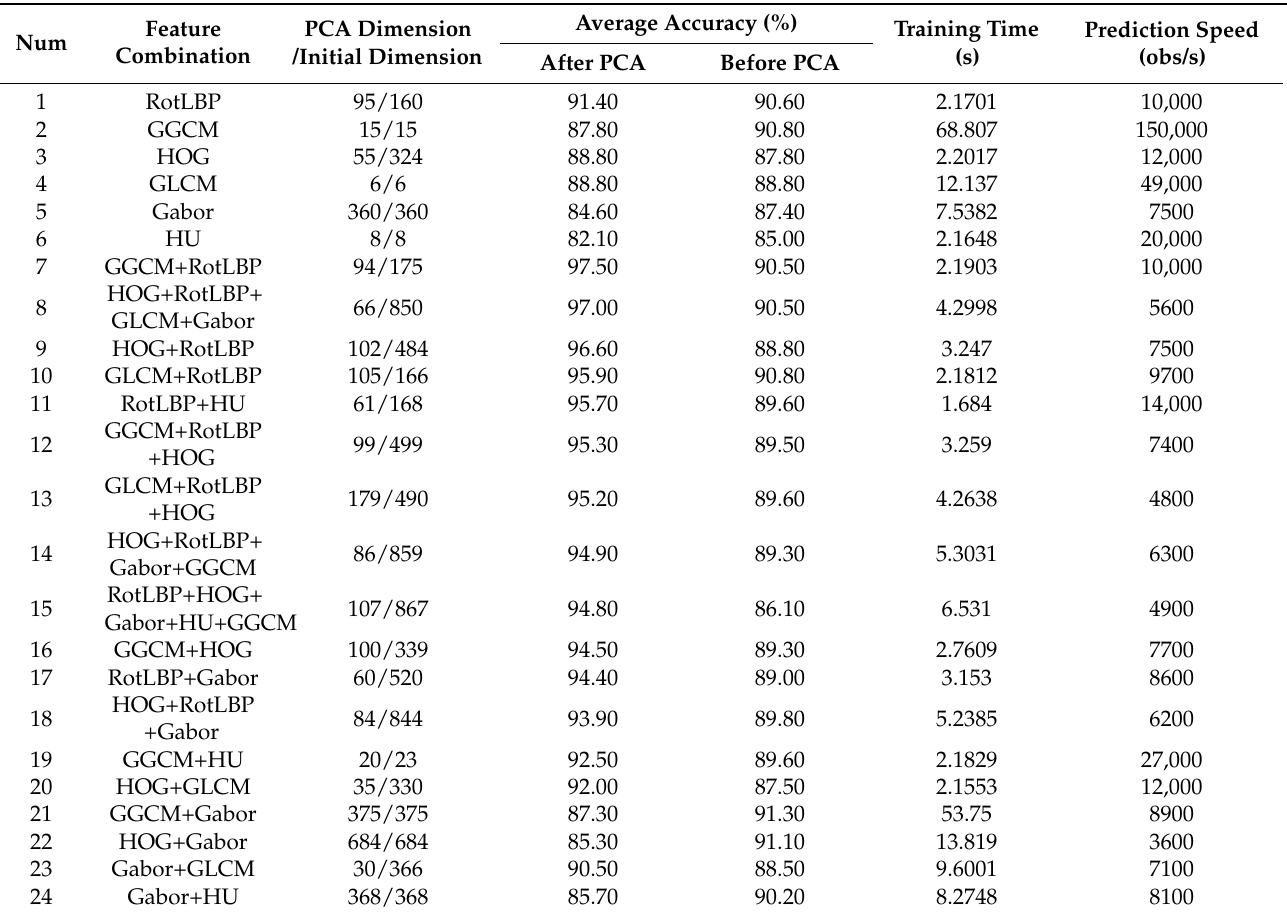
Table 5. Test accuracy and time consumption of each group of